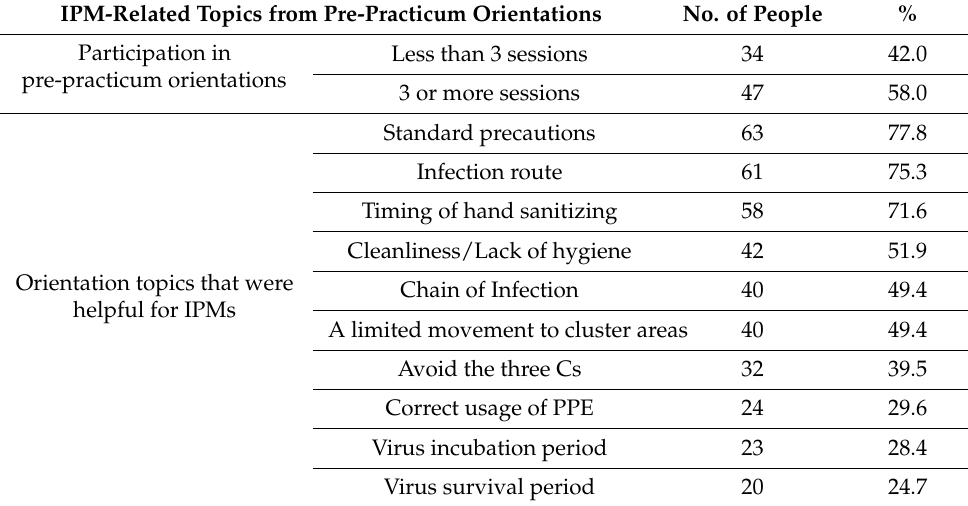
Table 3. Overview of pre-practicum orientations.